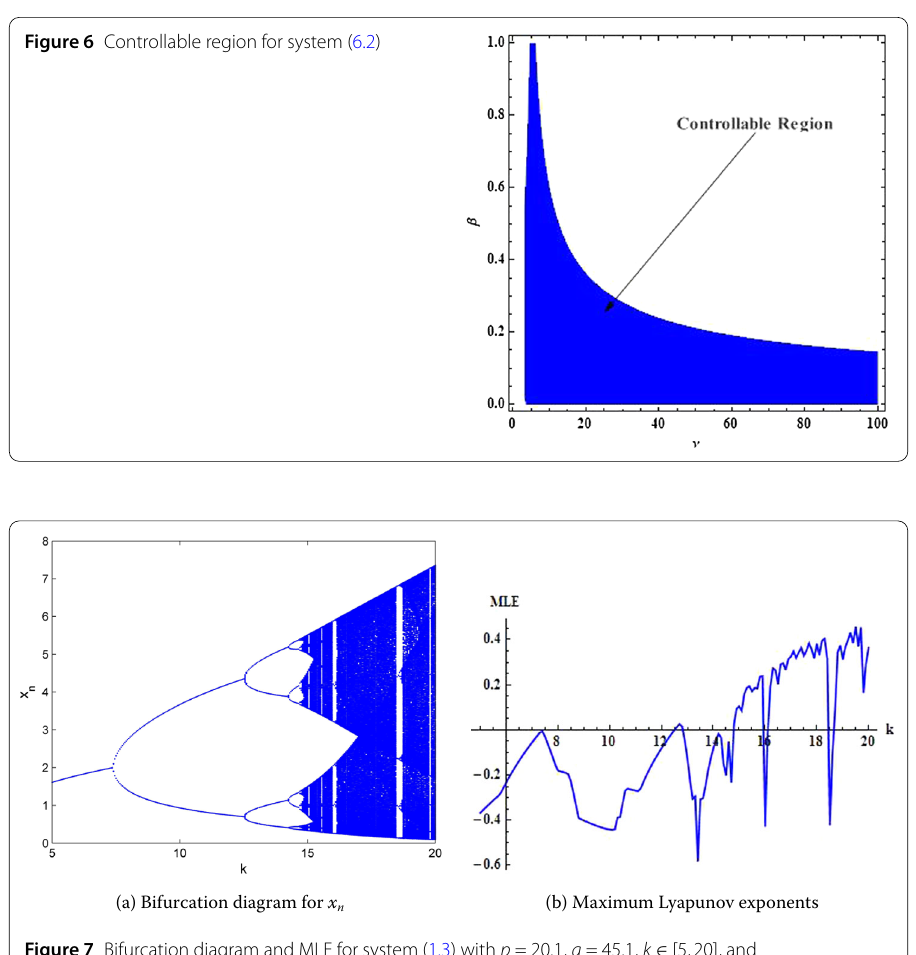
Figure 7 Bifurcation diagram and MLE for system (1.3) with p = 20.1, q = 45.1, k ∈ [5,20], and ( x 0 , y 0 ) =